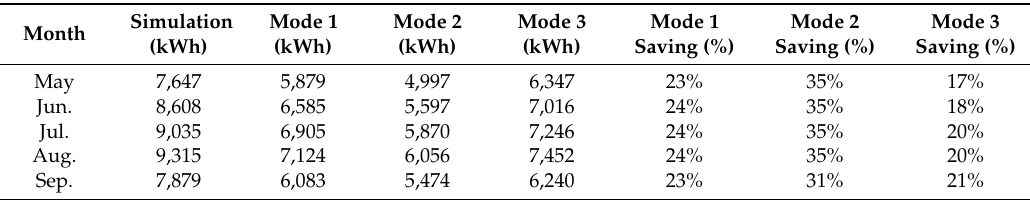
Table 8. Monthly energy consumption under the continuous and different modes of AC operation for Villa during the